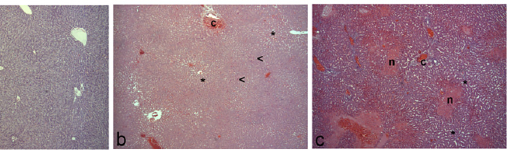
Fig 2. Representative microscopic images of control, PVL, and ALPPS atrophic lobes at 24 HPS. In ( a ) control liver, areas of congestion and sinusoid dilation (asterisks) could be observed. ( b ) In PVL atrophic lobes, scattered areas of degenerative hepatocytes (arrow heads) can be evidenced. ( c ) In ALPPS ones pericentrilobular areas of necrosis (n) surrounding the centrolobular vein (c) were present. (a,b,c): hematoxylin and eosin stain.